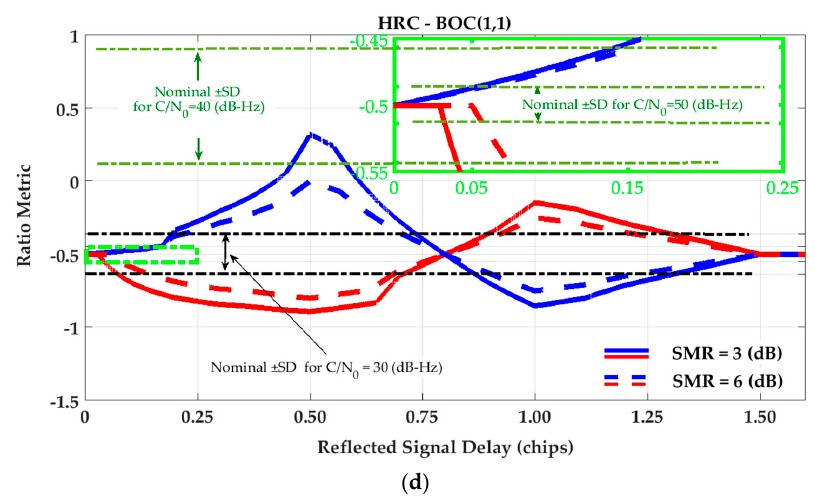
Figure 2. SQM variation envelopes of (single-sided) Ratio metric for ( a ) Narrow Correlator (NC) tracking strategy and BPSK(1) signaling; ( b ) Narrow Correlator (NC) tracking strategy and BOC(1,1) signaling; ( c ) High Resolution Correlator (HRC) tracking strategy and BPSK(1) signaling; ( d ) High Resolution Correlator (HRC) tracking strategy and BOC(1,1) signaling.